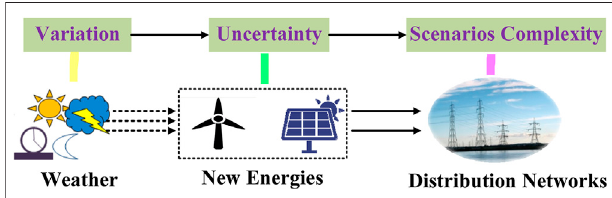
FIGURE 1 | Uncertainty in a new energy distribution